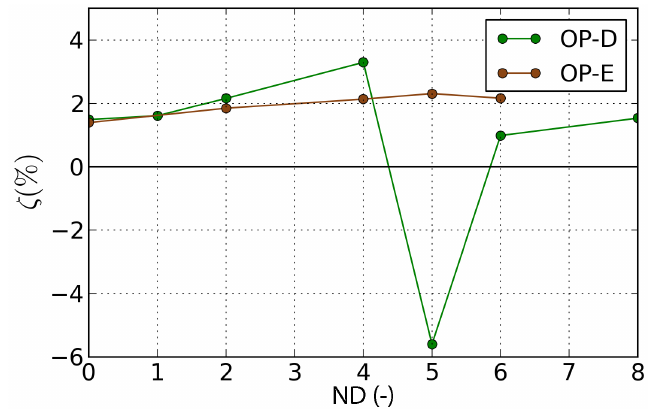
Figure 19. Mode 2 aerodynamic damping at OP-D and